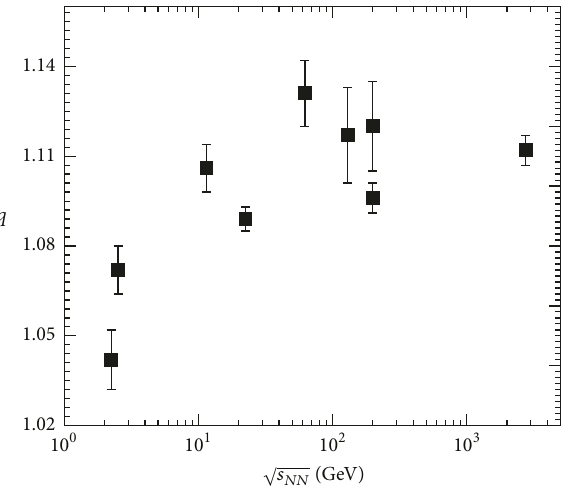
Figure 8: Dependence of 𝑞 on √𝑠 𝑁𝑁 . The symbols represent the values of parameter taken from Table 1 and the error bars represent the statistical